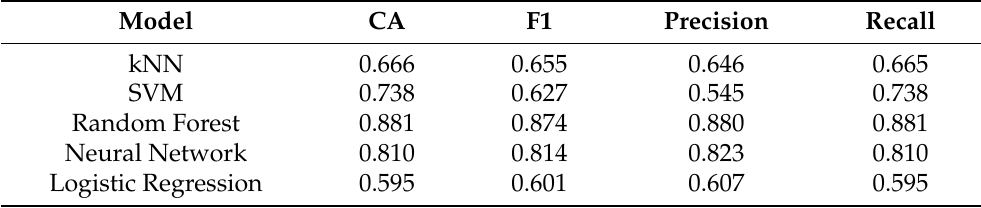
Figure 5. PCoA analysis: ( top ) the median value for the three categories of subjects respect to the abundance bacterial genera; and ( bottom ) the same analysis but considering each of the children and in relation to their sibling. The pairs of twins are linked by colored lines. Random colors are used to highlight the two pairs of twins. Table 2. Results of the accuracy of the 5 model used in this study. We have used different measures: Classification accuracy (CA), F1, precision, and